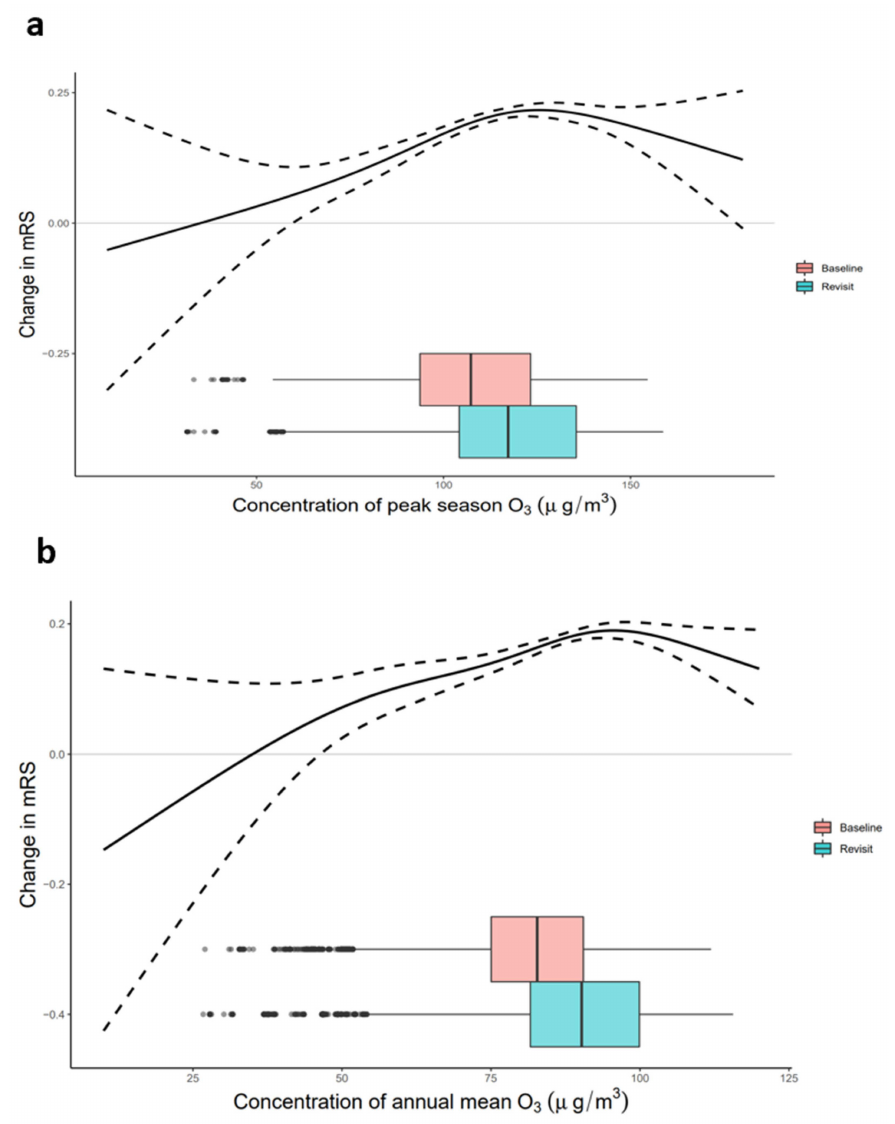
Figure 4. Exposure − response curves for O 3 exposure levels with mRS score. The solid line represents the point estimates; the dashed line represents the confidence intervals. The distribution of O 3 concentration of the baseline and revisit population are shown in the box plot. ( a ) Peak-season O 3 . ( b ) Annual mean O 3 . Models were adjusted for the interaction of the follow-up period with age at baseline, the interaction of the follow-up period with years after stroke at baseline, season of the study, smoking, drinking, physical activity, milk intake, body mass index, hypertension, diabetes, dyslipidemia, and atrial fibrillation. mRS, modified Rankin